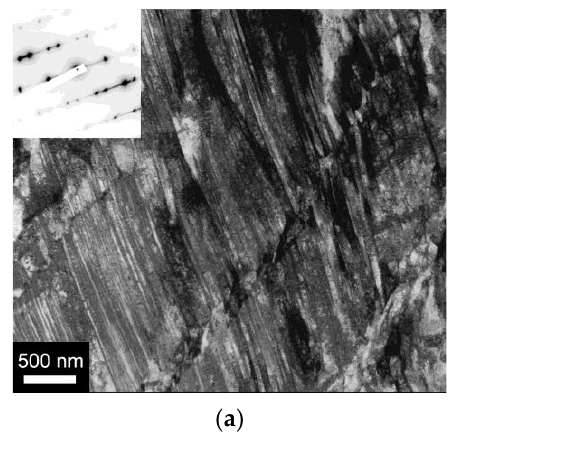
Figure 14. Deformation twinning ( a ) and microshear banding ( b ) in a 304L stainless steel subjected to cold rolling to a strain of 0.5 and 1.0, respectively.